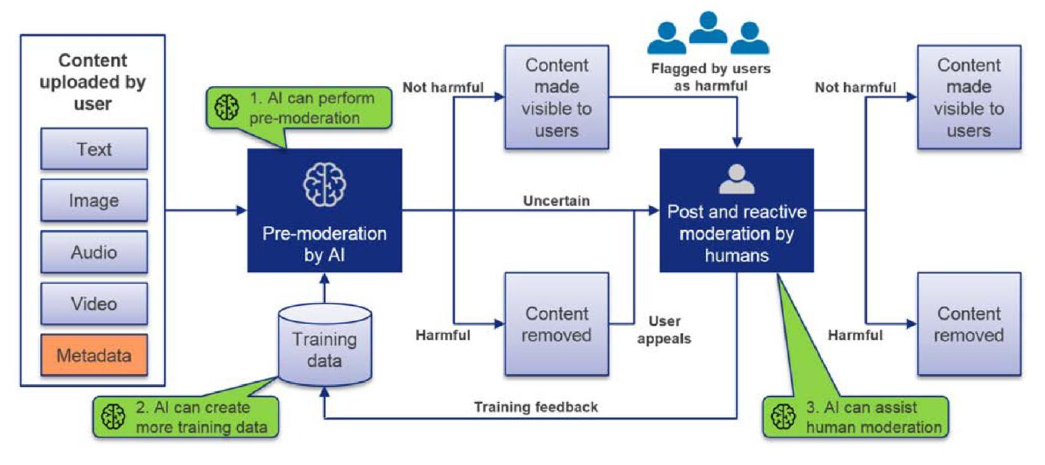
Figure 2: Ideal Flowchart for Moderation (Source: Cambridge Consultants